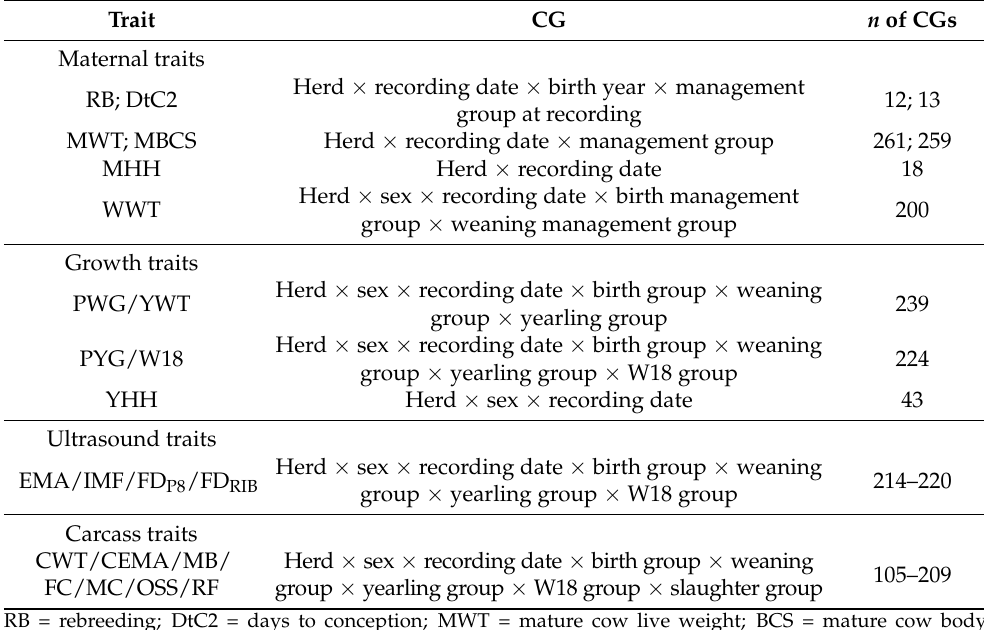
Table 1. Contemporary group (CG) definitions for maternal, growth, ultrasound and carcass traits and number ( n ) of CGs.